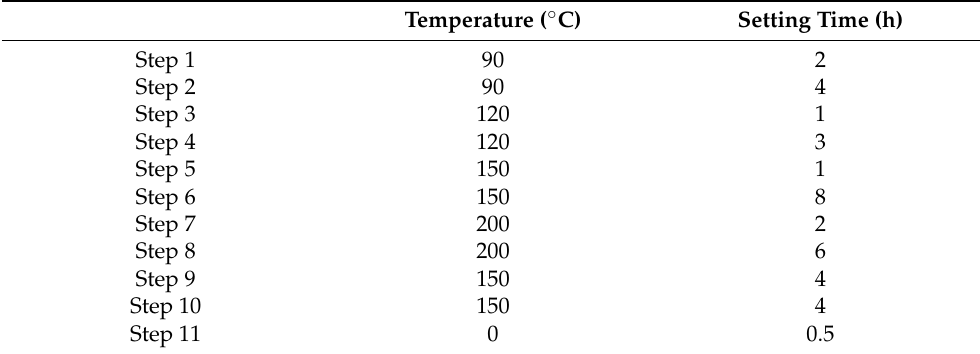
Figure 1. FDM-modeled PEEK (0° PF, 45° PF, and 90° PF). Table 3. Annealing process schedule.